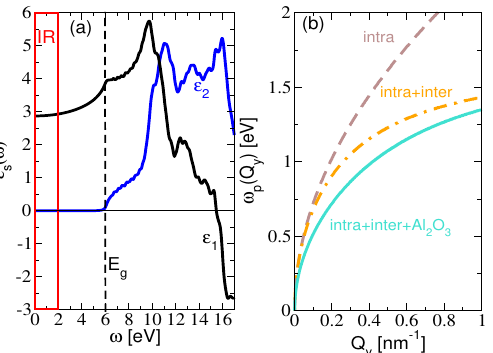
Figure 3. ( a ) Ab initio macroscopic dielectric function (cid:101) s ( ω ) = (cid:101) 1 ( ω ) + i (cid:101) 2 ( ω ) of the bulk Al 2 O 3 crystal. Red frame denotes the frequency range of the IR active plasmons studied here; ( b ) Dispersion relations of the Dirac plasmon in the KC 8 -SL obtained from the maxima of the real part of the screened conductivity (26), where σ 0 = σ intra and Γ = Γ 0 (brown dashed), σ 0 = σ intra + σ inter and Γ = Γ 0 (orange dashed-dotted) and σ 0 = σ intra + σ inter and Γ = Γ 0 + Γ sc (solid turquoise).